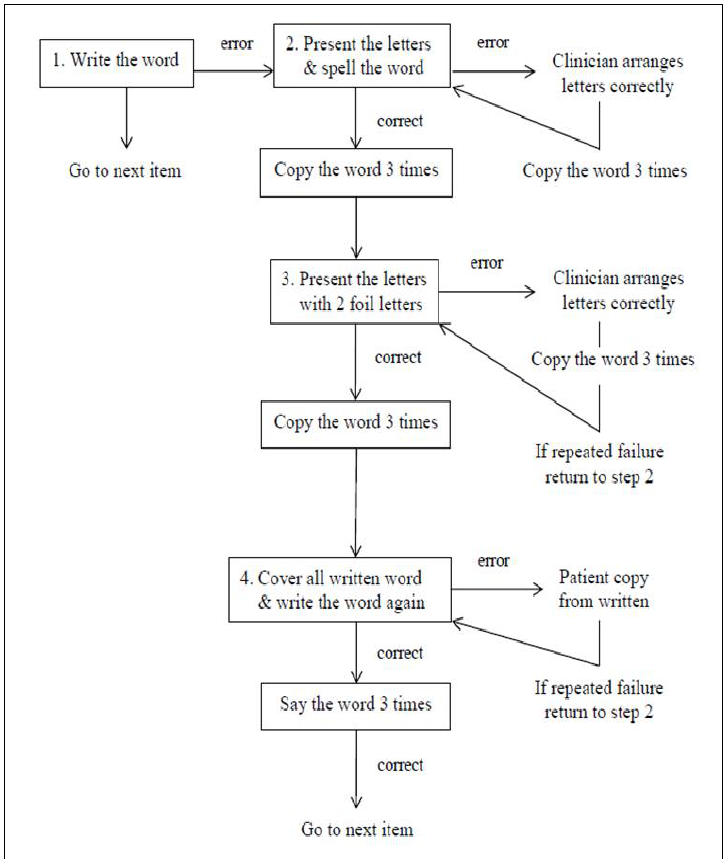
Figure 3. Schematic representation of the anagram and copy treatment (ACT) adapted from [12].